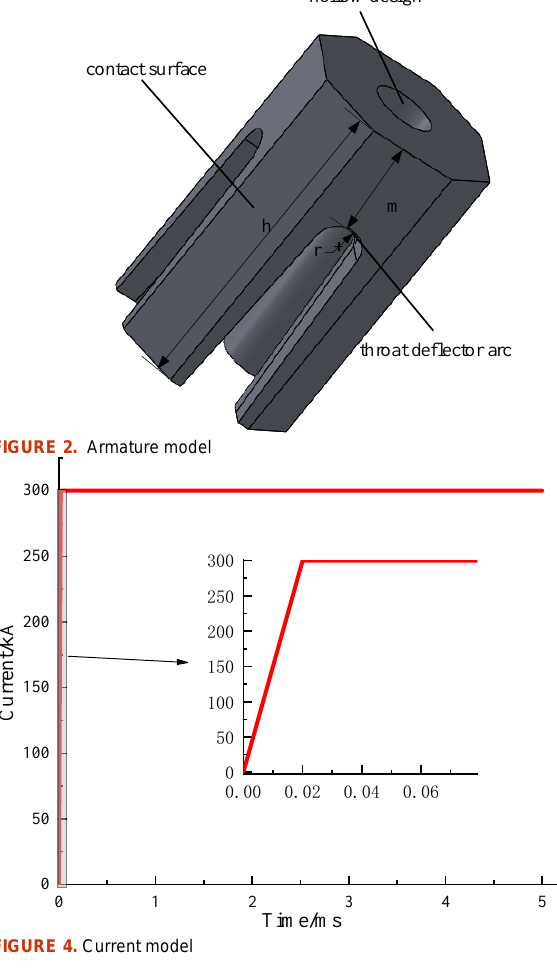
FIGURE 4. Current